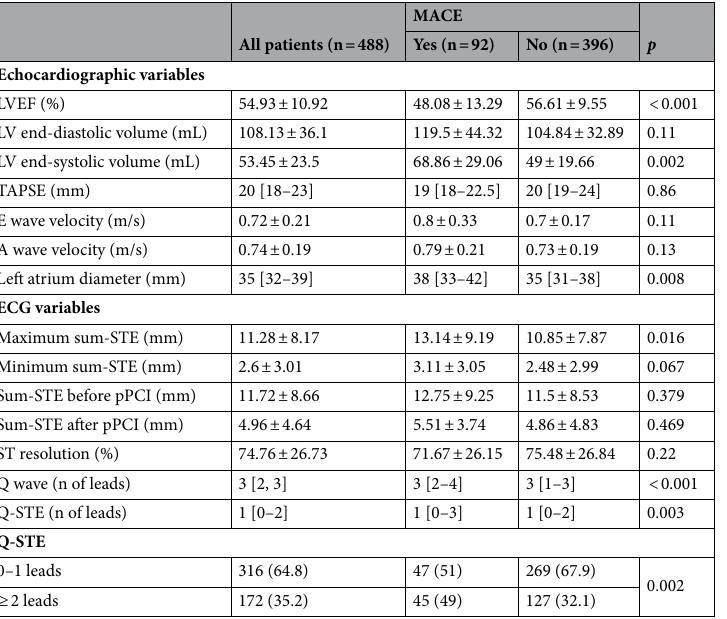
Table 2. Echocardiographic and ECG variables before discharge. Categorical variables are presented as a number (percentage). Continuous parametric variables are presented as mean ± standard deviation. Continuous non-parametric variables are presented as median [interquartile range]. LV Left ventricular, LVEF Left ventricular ejection fraction, MACE Major adverse cardiovascular events, pPCI Primary percutaneous coronary intervention, Q-STE Q wave and residual STE > 1 mm, Sum-STE Sum of ST-segment elevation, TAPSE Tricuspid annular plane systolic excursion. E and A wave velocities were not considered for analyses in patients with atrial fibrillation at the time of